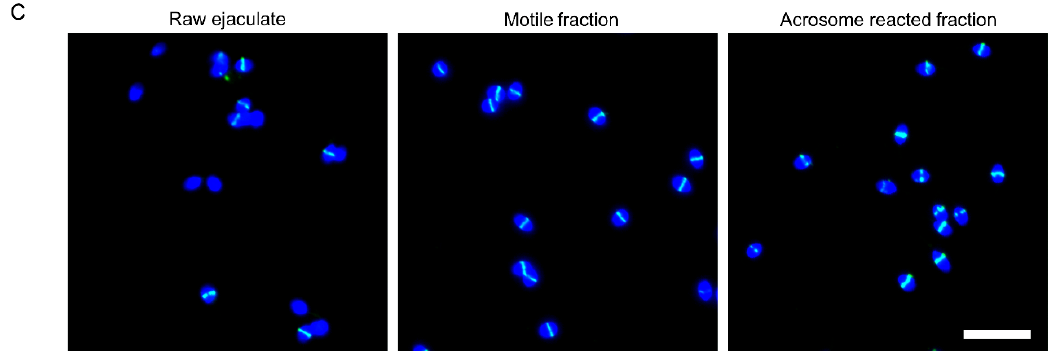
Figure 2. Expression of GalNAc-T3 on spermatozoa in swim-up fractions and after acrosomal exocytosis. ( A ) Ejaculates from 4 laboratory quality control (QC)-donors were evaluated for equatorial GalNAc-T3 expression before and after swim-up selection. Three of the samples were further evaluated after incubation with the ionophore ionomycin, which induces the acrosome reaction. ( B ) Bar plot showing the fold enrichment of GalNAc-T3-positive spermatozoa in the motile and the acrosome-reacted fractions relative to the raw ejaculate. Error bars indicate the standard error of the mean. ( C ) Representative immunofluorescence images of GalNAc-T3 expression detected with mAb 2D10 in the raw ejaculate, the motile fraction and the acrosome-reacted fraction. Nuclei of the spermatozoa were stained with DAPI. Scale bar 20 µm.